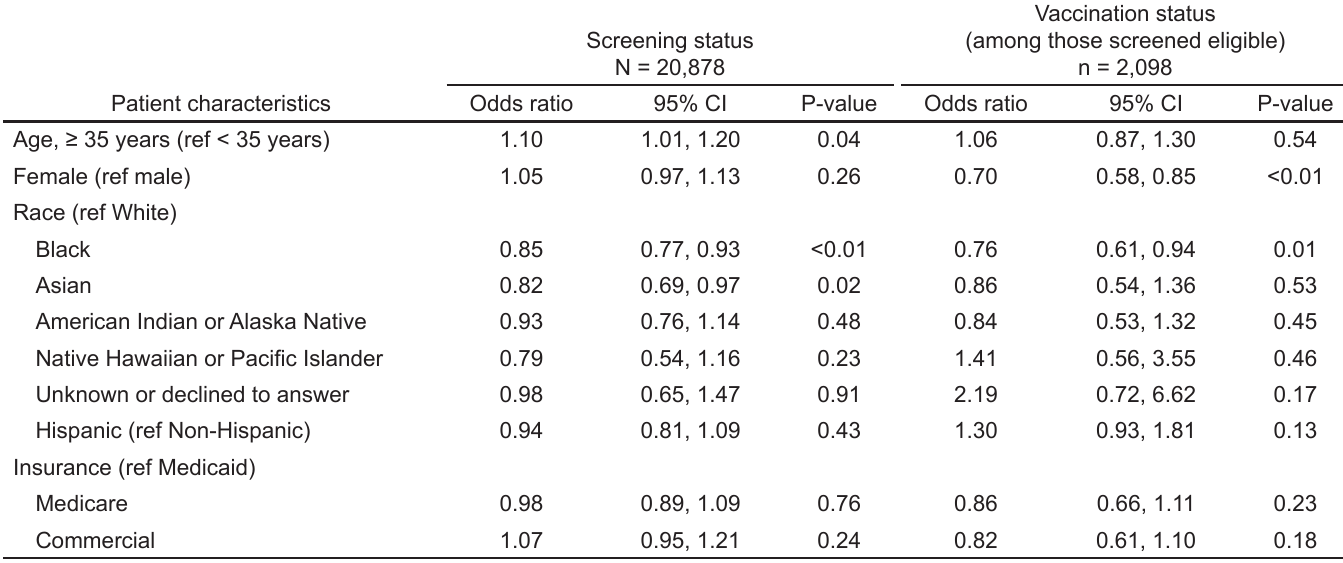
Table 2. Associations between patient characteristics and screening and vaccination status from adjusted